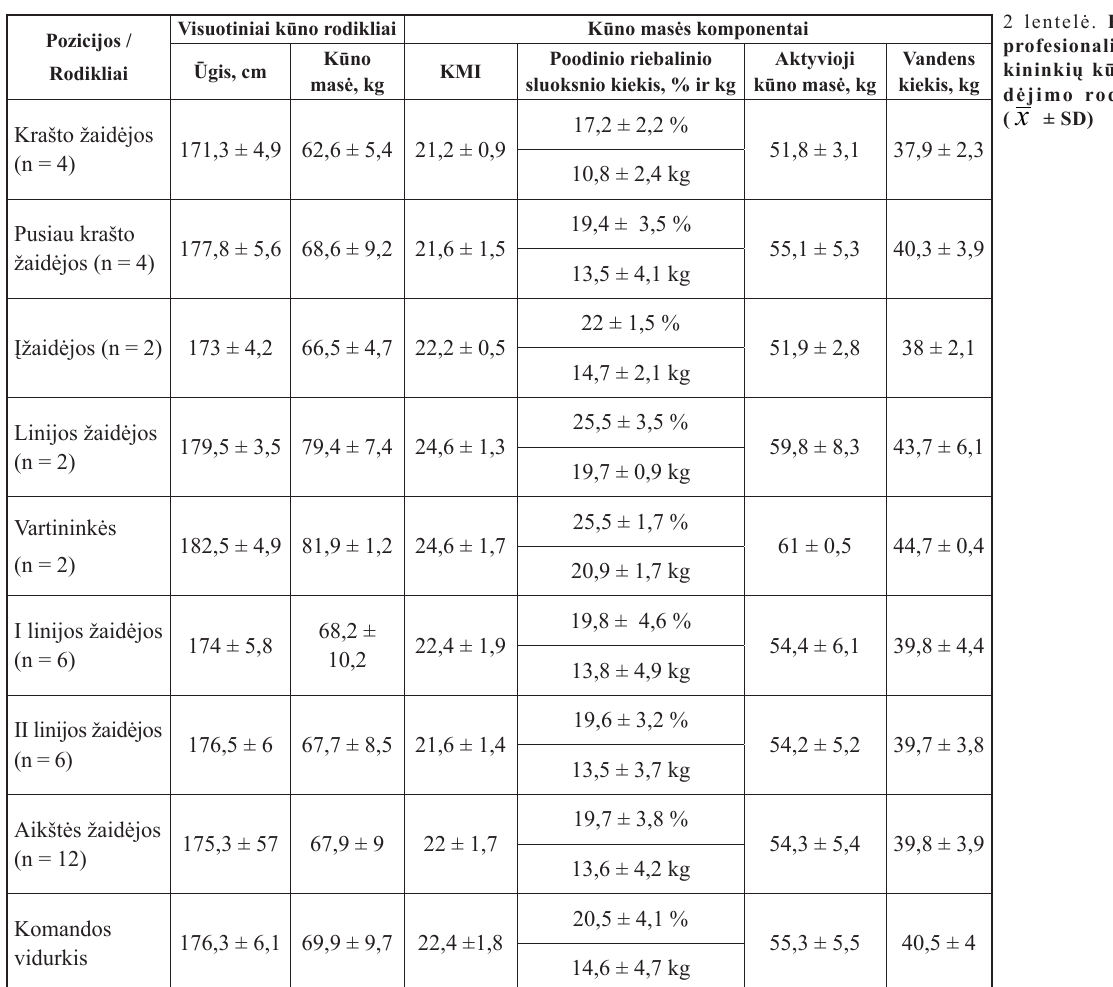
Yo-Yo nutr ū kstamo intensyvumo ištverm ė s ir atsigavimo testai (I lygio). Atlikdamos ištver- m ė s test ą , žaid ė jos vidutiniškai nub ė go 1593 ± 566 m (3 lent.). Aikšt ė s žaid ė jos nub ė go 620 m daugiau nei vartinink ė s (1060 ± 594 m). II lini- jos žaid ė jos nub ė go 112 m daugiau nei I linijos žaid ė jos (1664 ± 483 m). Žaid ė j ų laktato koncen- tracija kraujyje po testo vidutiniškai buvo 10,4 ± 2,8 mmol / l. Aikšt ė s žaid ė j ų laktato koncentracija kraujyje buvo 3,4 mmol / l didesn ė nei vartininki ų (7,6 ± 4,5 mmol / l). Atlikdamos Yo-Yo atsigavimo test ą , žaid ė jos vidutiniškai nub ė go 554 ± 204 m. Aikšt ė s žaid ė jos nub ė go 253 m daugiau nei varti- nink ė s (320 ± 0 m). I ir II linijos žaid ė jos nub ė go beveik tiek pat (584 ± 220 ir 573,3 ± 201 m). Žai- d ė j ų laktato koncentracija kraujyje po atsigavimo testo buvo 3,4 mmol / l (vidutiniškai — 13,8 ± 2,7 mmol / l) didesn ė negu po ištverm ė s testo. Aikšt ė s žaid ė j ų laktato koncentracija kraujyje buvo 0,5 mmol / l mažesn ė nei vartininki ų . I linijos žaid ė j ų (10,8 ± 2,02 mmol / l) laktato koncentra- cija kraujyje po ištverm ė s testo buvo 0,4 mmol / l mažesn ė nei II linijos (11,2 ± 2,8 mmol / l).